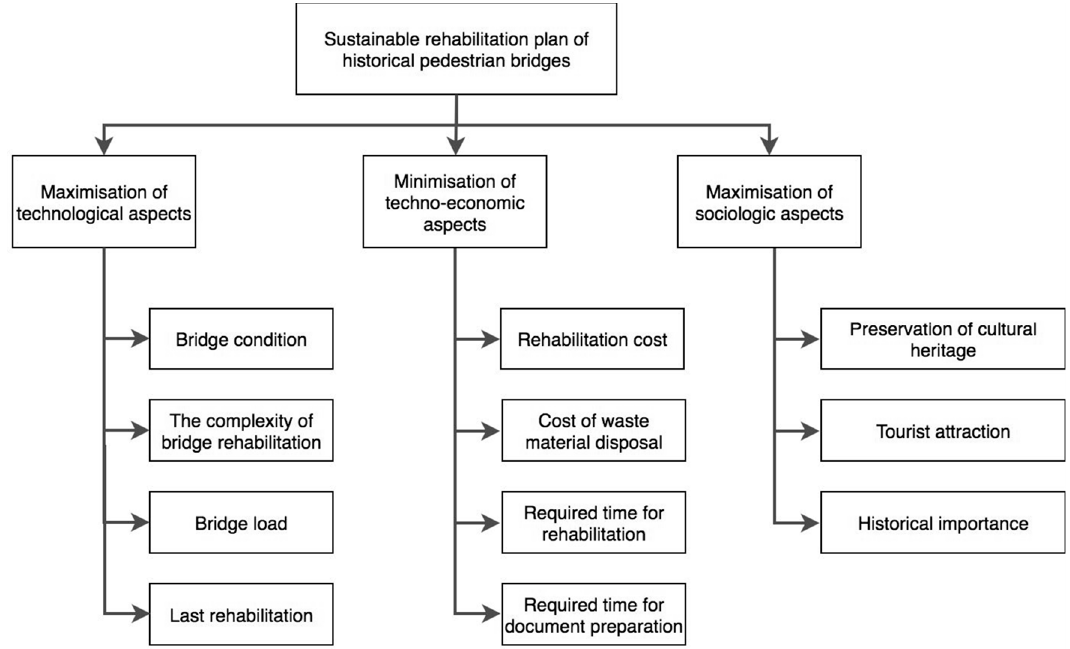
Figure 3. The goal hierarchy structure for the rehabilitation planning of historical pedestrian bridges.